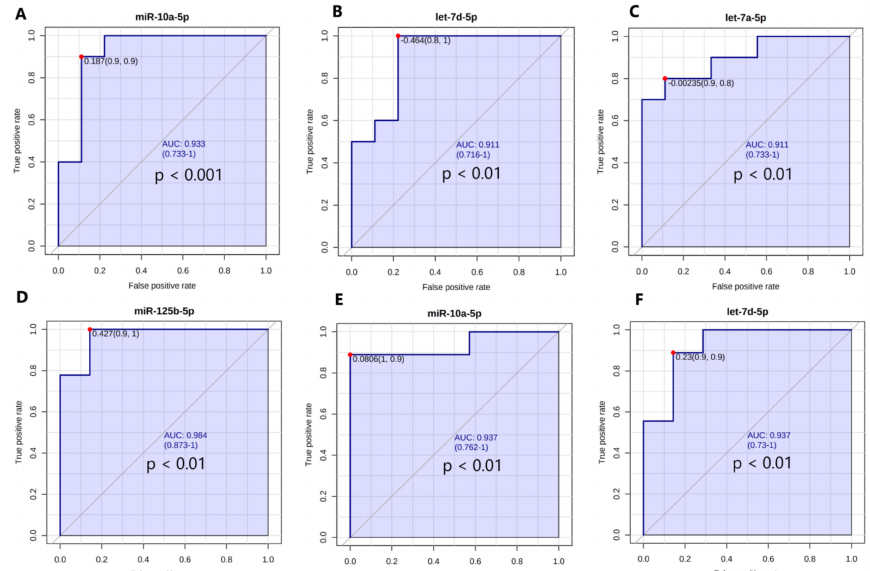
Figure 7. Biomarker analyses indicating 3 top miRNAs as potential VAT-specific markers of T2DM (T2DM vs. NG subjects) ( A – C ) as well as IFG (IFG vs. NG subjects) ( D – F ) in female subjects (N = 26) ranked according to area under ROC curve (AUROC). Optimal cutoff was calculated according to “closest to top—left corner method”. ( A ) miR-10a-5p, ( B ) let-7d-5p, ( C ) let-7a-5p, ( D ) miR-125b-5p, ( E ) miR-10a-5p, ( F ) let-7d-5p. Graphs were generated by Metaboanalyst 4.0.